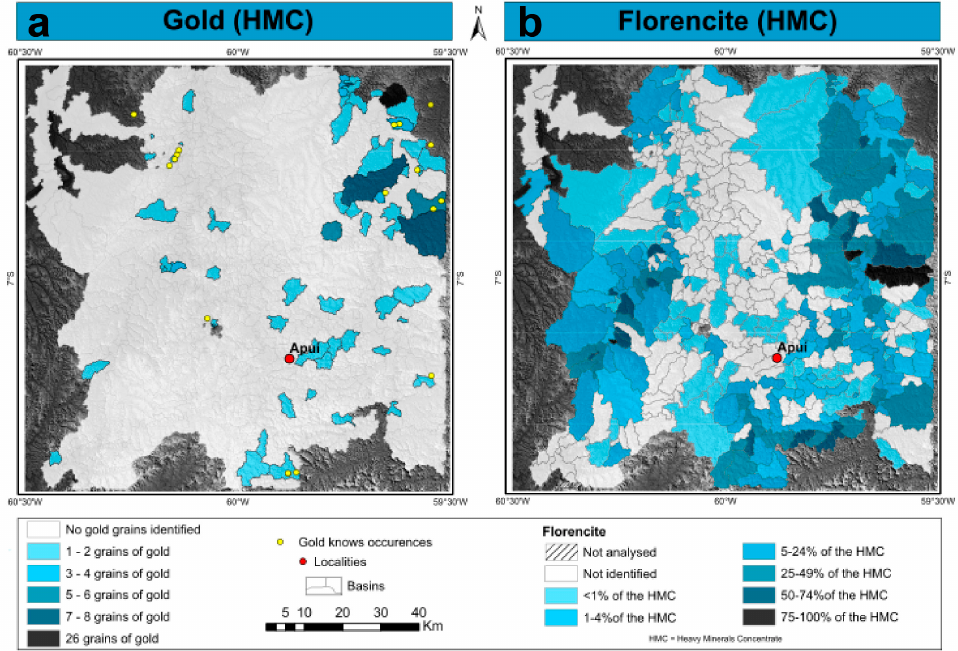
Figure 4. Spatial distributions for heavy mineral concentrates (HMC) are shown through maps of the corresponding hydrographic basins for each sample; ( a ) Gold HMC; ( b ) Florencite HMC.